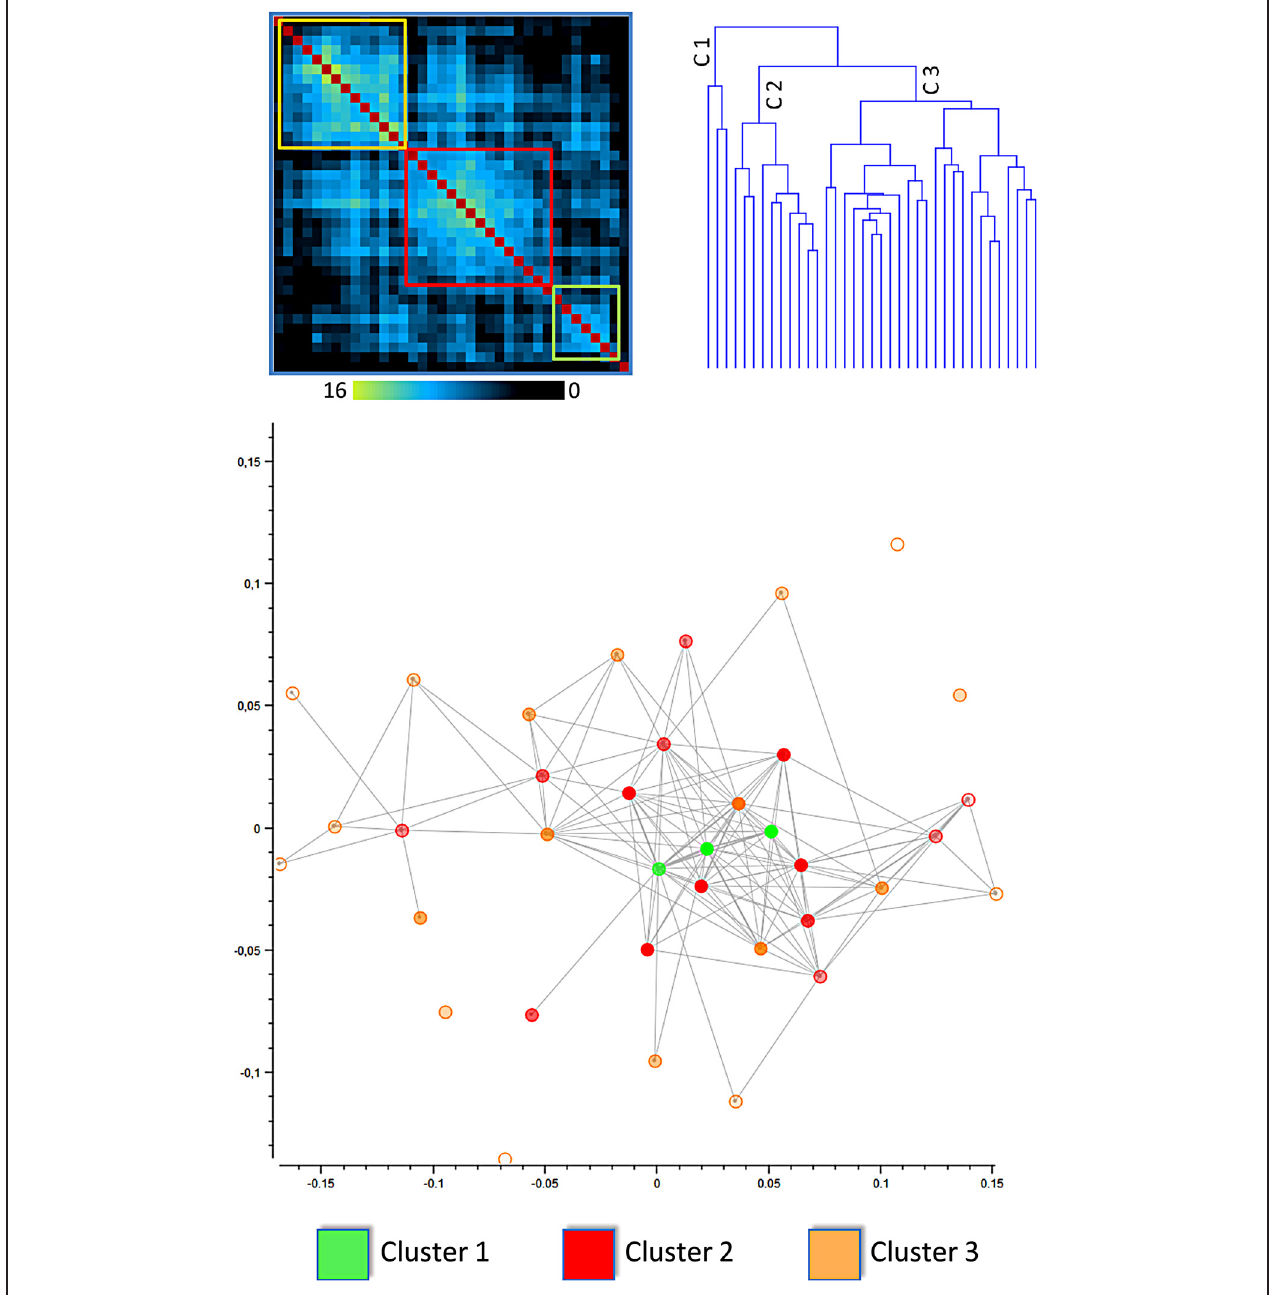
scaling of the network derived from the distance between blocks of the cingulate cortex. The points represent blocks and are coded with a color indicating the cluster to which they belong. In this image the distance between points represents the Euclidean distance between the MACM maps of each